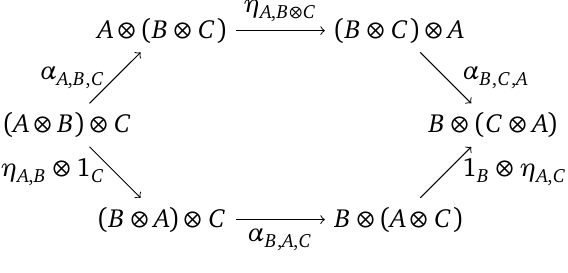
Figure 3: The first hexagon